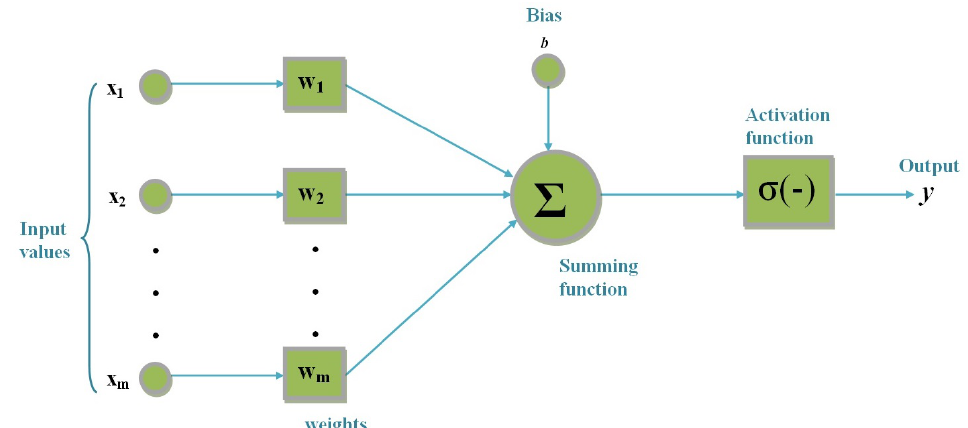
Figure 1. General structure of an artificial